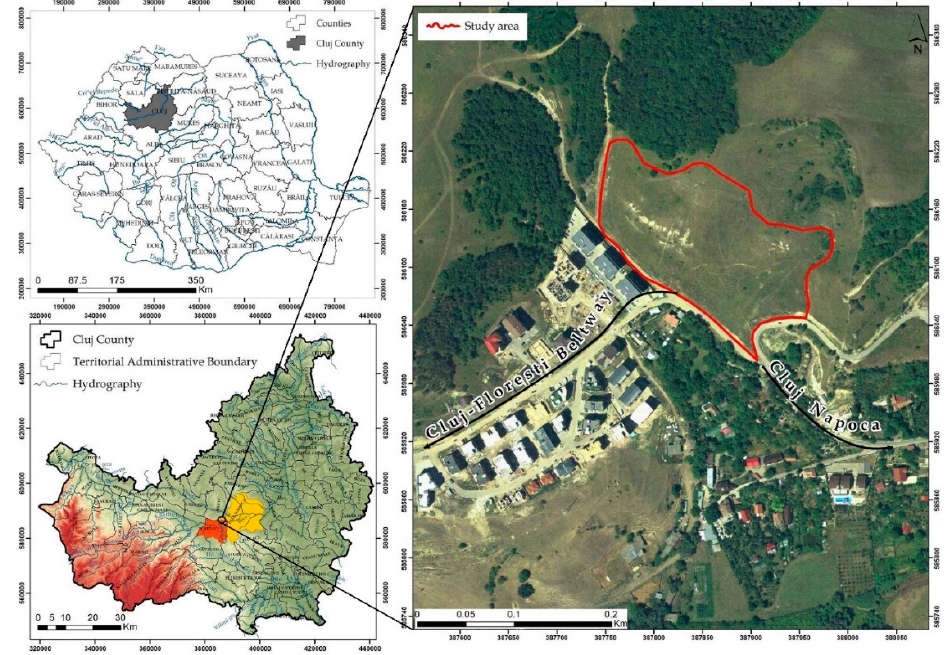
Figure 1. The geographic location of the study area.